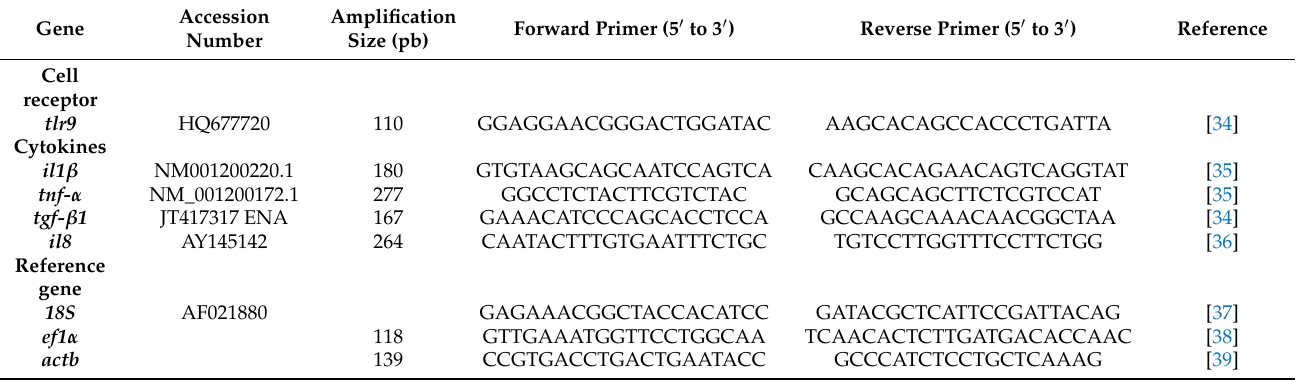
Table 3. Primers used for real time qPCR